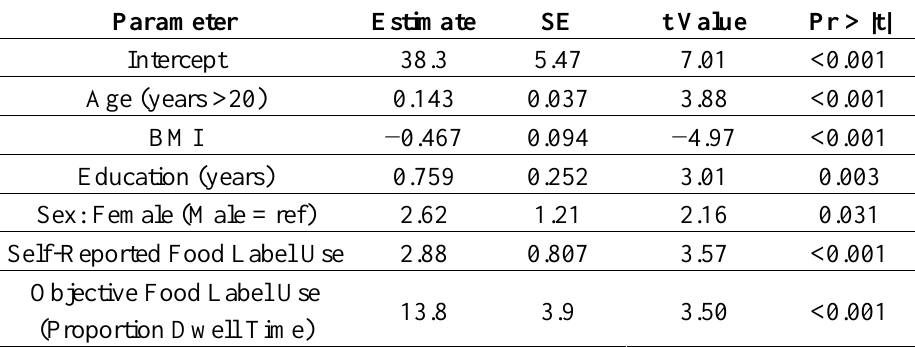
Table 2. Covariates of the Healthy Eating Index, Linear Regression